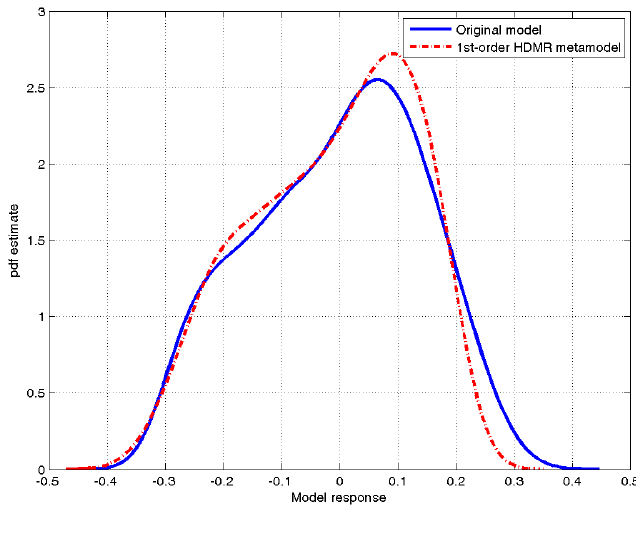
Figure 5. Example of fit for of a first order HDMR metamodel for tablet API concentration in a direct compaction process obtained using the GUI-HDMR software of Ziehn and Tomlin